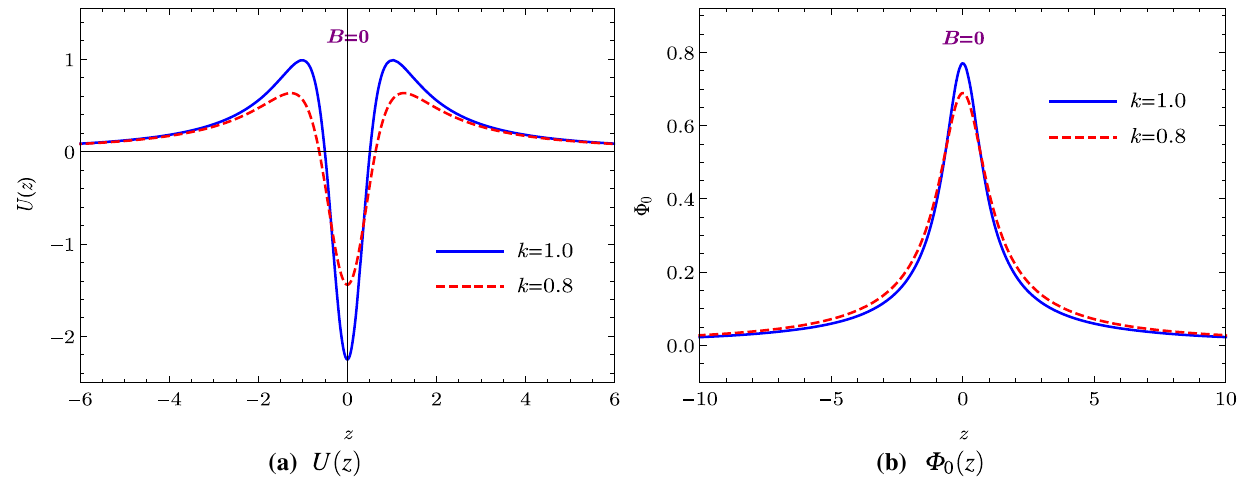
Fig. 6 The profiles of the effective potential U ( z ) and gravitational zero mode (cid:19) 0 ( z ) for the case of B = 0 constant reads G 5 = G 4 / N 2